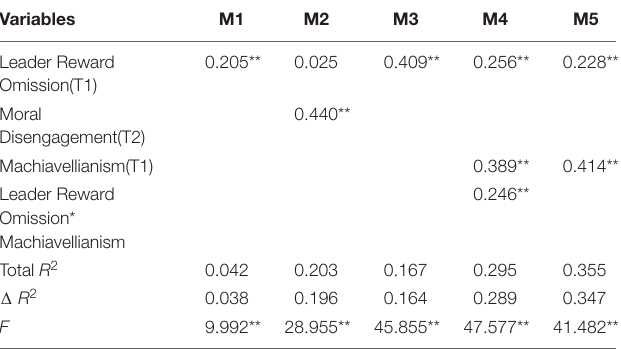
TABLE 3 | Regression results for model predicting deviant behavior.